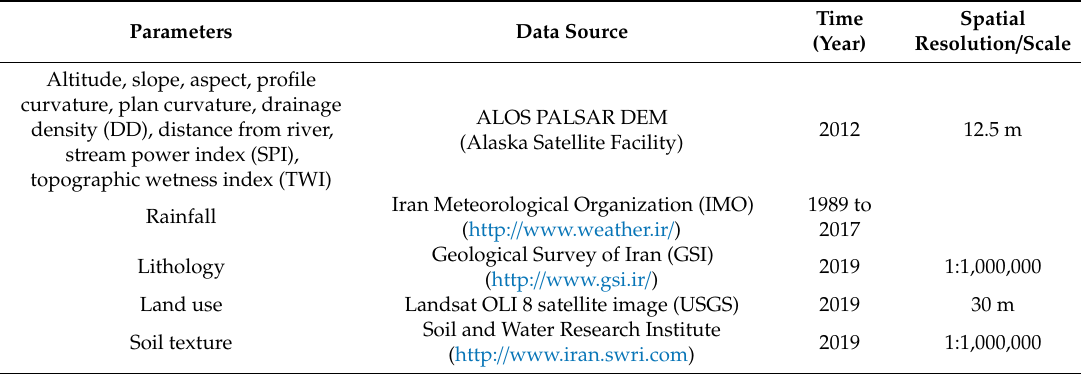
Table 2. Details about the data sources of several factors used in this